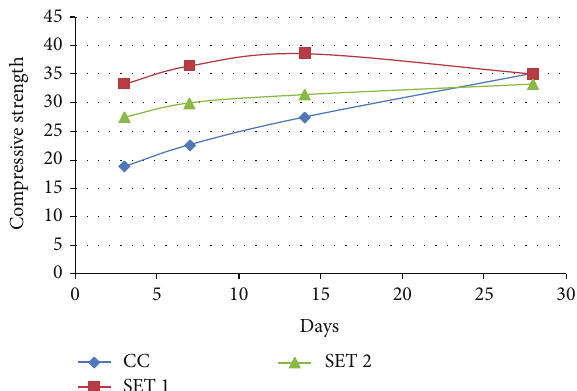
Figure 2: Comparison of control concrete with Set 1 and Set 2.